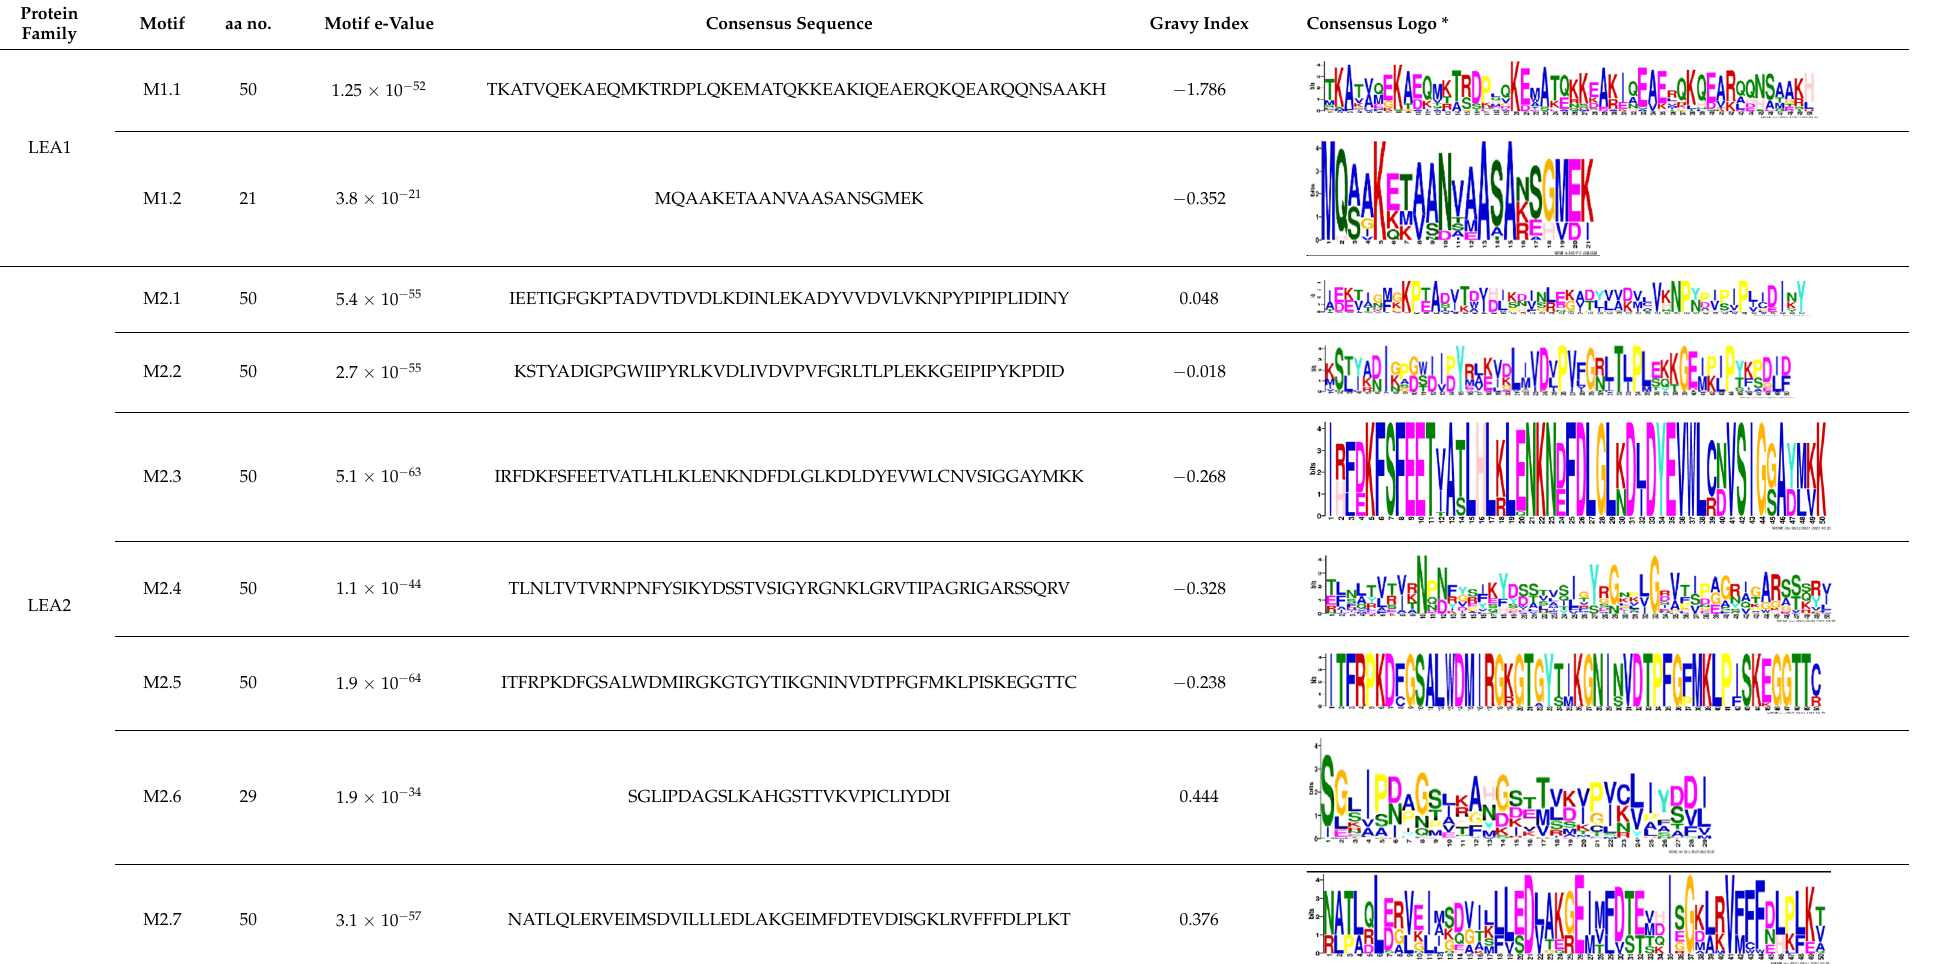
Table 3. A consensus sequence of the different motifs features of each R. serbica LEA protein family.